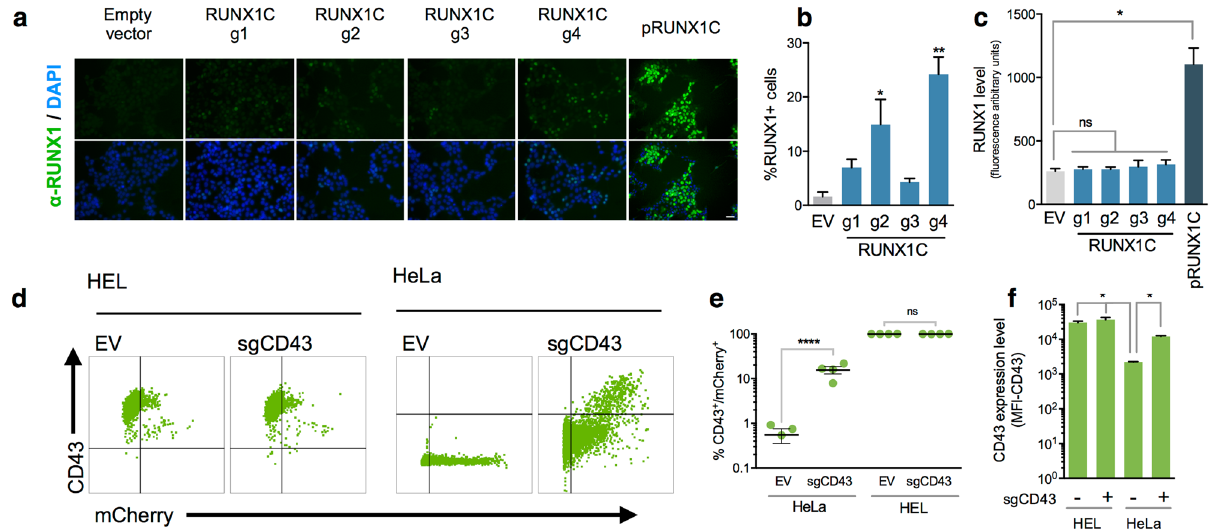
Figure 2. UniSAM gene activation results physiological levels of protein expression. ( a ) Immunocytochemistry analyses of HEK293T cells transfected with the UniSAM carrying no gRNA (empty vector (EV)) or a single gRNAs directed to RUNX1c (n = 4 for each of the gRNAs, g1 to g4) or a CMV-driven pRUNX1c expression plasmid (scale bar, 50 μ m). ( b ) Percentage of RUNX1 + cells following transfection of UniSAM vectors carrying gRNA 1–4) (n = 4, Kruskal Wallis One-way ANOVA, * p < 0.05, ** p < 0.01). ( c ) Comparison of RUNX1 expression levels in individual cells mediated by UniSAM and CMV-driven pRUNX1c expression plasmid analysed by Columbus Image Analysis Software (n = 4, Kruskal Walis One-way ANOVA, ns p > 0.5; * p < 0.03). ( d ) Flow cytometry analysis of HEL and HeLa cells transfected with the empty vector (EV) or a UniSAM containing a sgRNA for CD43. ( e ) Quantification of the proportion of CD43 + cells in (d) (n = 4; Sidak’s two-way Anova, **** p < 0.0001). ( f ) Quantification of CD43 expression level (assessed by mean fluorescent intensity (MFI)) in HEL and HeLa cells after activation (n = 4; Dunn’s one-way Anova; * p >